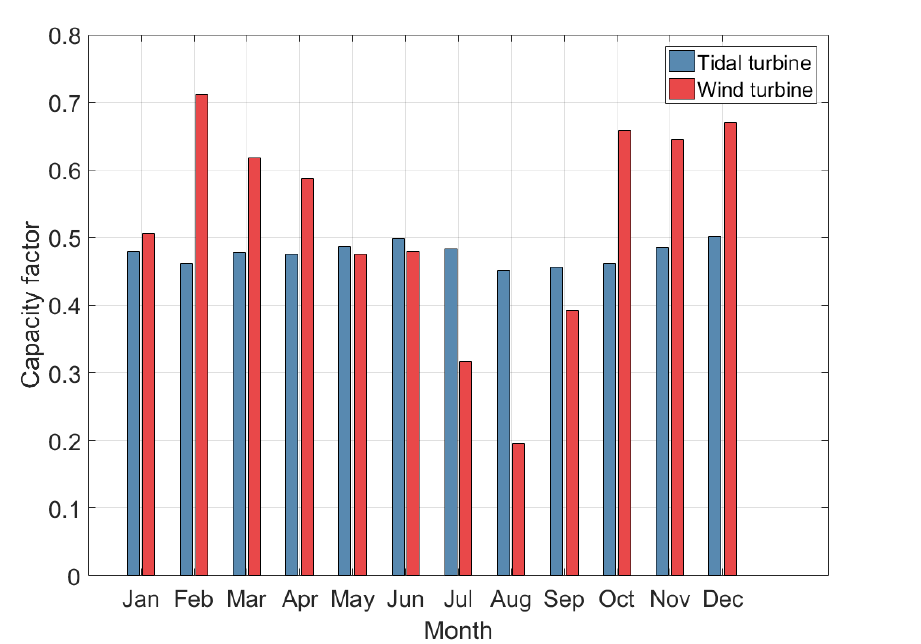
Figure 6. Monthly tidal and wind power capacity factors over